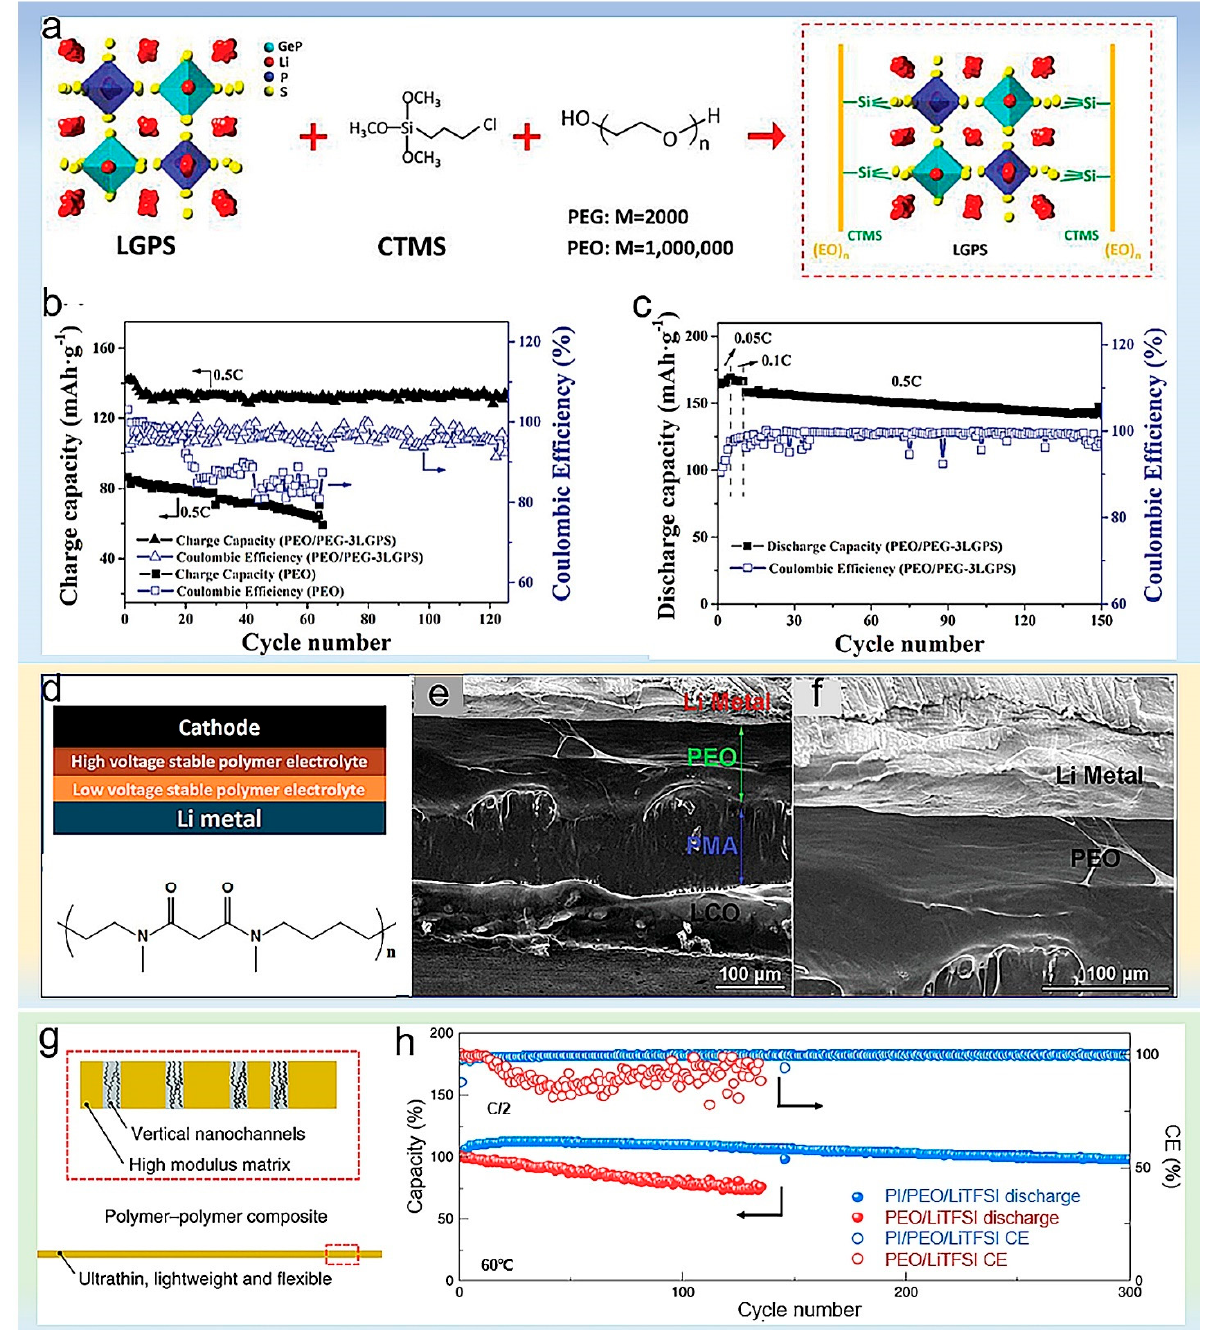
Figure 9. ( a ) Schematic illustration of the as-prepared HSE structure. ( b ) Capacity and Columbic efficiency versus cycle number of the LTO|PEO/PEG-3LGPS|Li cell and LTO|PEO|Li cell at 0.5 °C. ( c ) Capacity and Columbic efficiency versus cycle number of the LFP|PEO/PEG-3LGPS|Li cell at 0.05 °C, 0.1 °C, and 0.5 °C. Reproduced with permission [82]. Copyright 2020, John Wiley and Sons. ( d ) Stacking model of DLPSE in an all-solid-state cell and molecular structure of PMA. ( e ) The cross-section images of a Li/PEO–LiTFSI/PMA–LiTFSI/LCO cell. ( f ) The cross-section images of a Li/PEO-LiTFSI/LCO cell. Reproduced with permission [84]. Copyright 2019, John Wiley and Sons. ( g ) Schematic showing the design principles of polymer–polymer composite solid-state electrolytes. ( h ) Capacity retention performance of Li/PI/PEO/LiTFSI/LFP and Li/PEO/LiTFSI/LFP cells at 0.5 °C, cycled at 60 °C [87]. Reproduced with permission. Copyright 2019, Springer Nature.